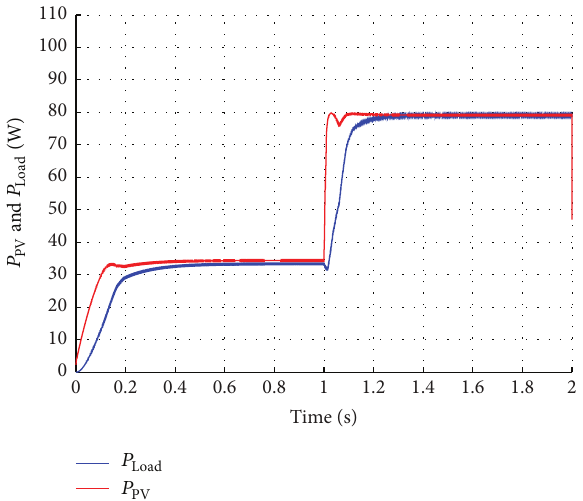
Figure 20: Power response when sudden temperature changes.